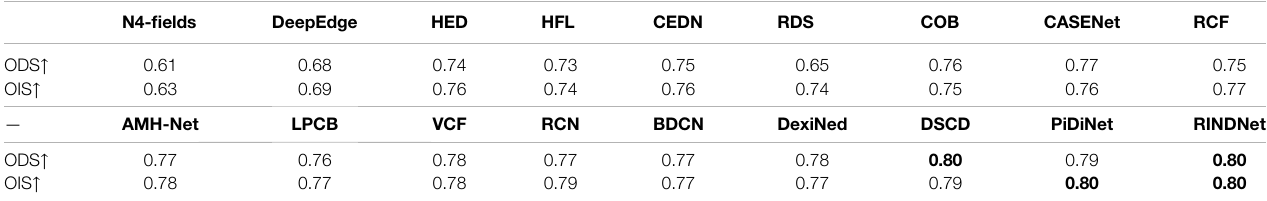
TABLE 4 | Performance comparison of deep learning-based edge detection algorithms on the NYUD